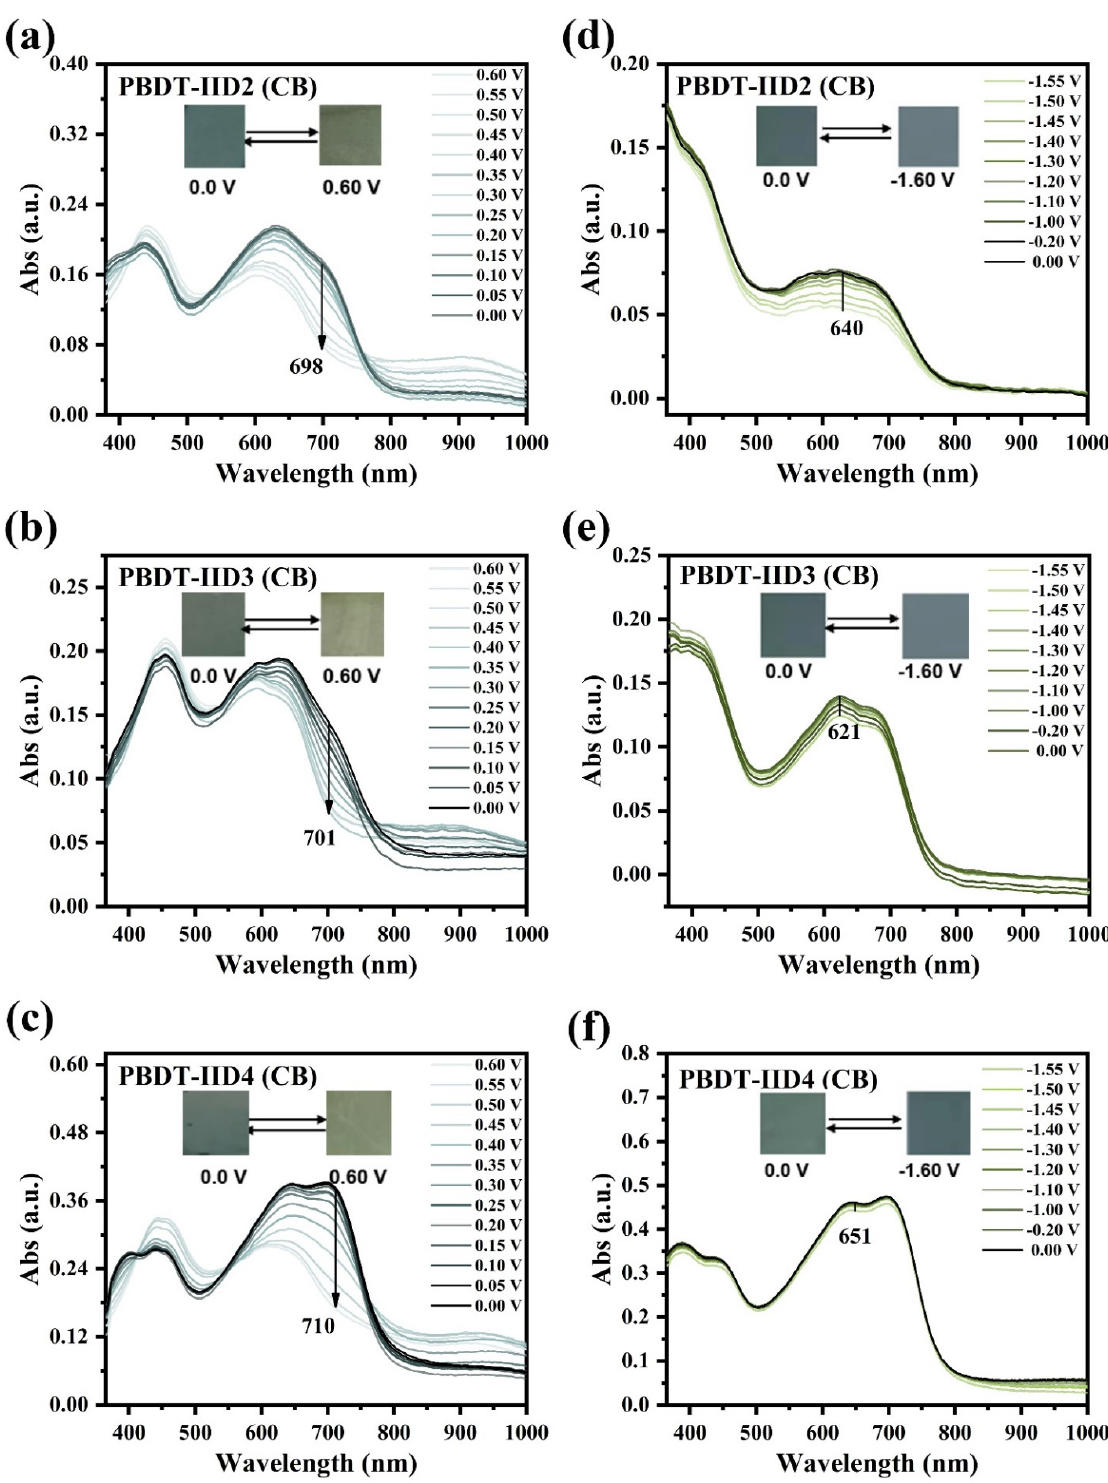
Figure 6. ( a ) UV-visible absorption spectra of PBDT-IID2 as a function of applied voltage (0–0.6 V); ( b ) UV-visible absorption spectra of PBDT-IID3 as a function of applied voltage (0–0.6 V); ( c ) UV-visible absorption spectra of PBDT-IID4 as a function of applied voltage (0–0.6 V); ( d ) UV-visible absorption spectra of PBDT-IID2 as a function of applied voltage ( − 1.6–0 V); ( e ) UV-visible absorption spectra of PBDT-IID3 as a function of applied voltage ( − 1.6–0 V); ( f ) UV-visible absorption spectra of PBDT-IID4 as a function of applied voltage ( − 1.6–0 V). The polymer films were processed using chlorobenzene and the test system was the same as the cyclic voltammetry test described